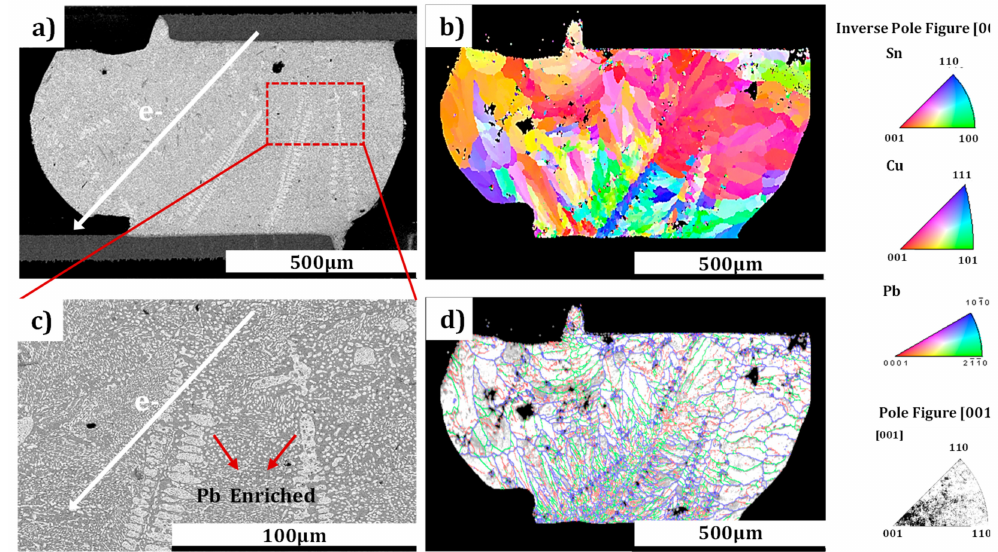
Figure 8. SEM images of Pb migration in a microbump of polycrystalline structure at CT. ( a ) and ( c ) are SEM images of the SnPb microbump (Pb content is 37%) after stressing at the current density of Figure 8a; and ( d ) characterization of the grain boundaries in the microbump of Figure